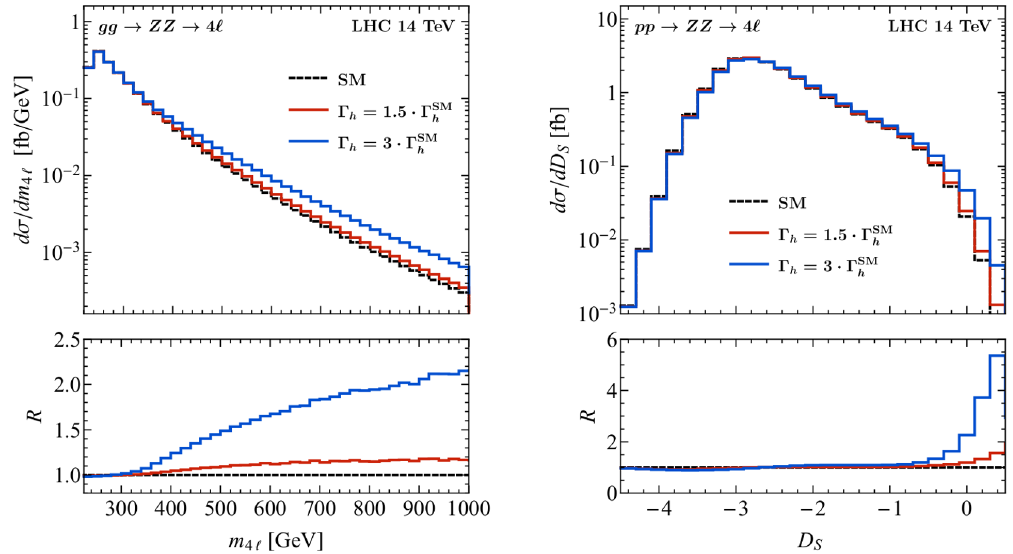
Figure 8. Left: m 4 ‘ distributions for the gg -initiated contributions in the SM (dashed black), for Γ h = 1 . 5 · Γ SM (solid red) and for Γ h = 3 · Γ SM h the pp → ZZ → 4 ‘ process in the SM (dashed black), for Γ h = 1 . 5 · Γ SM Γ h = 3 · Γ SM (solid blue). All distributions are obtained using (A.1), are LO QCD accurate and h √ assume pp collisions at s = 14 TeV . The lower panels show the ratios between the BSM and SM